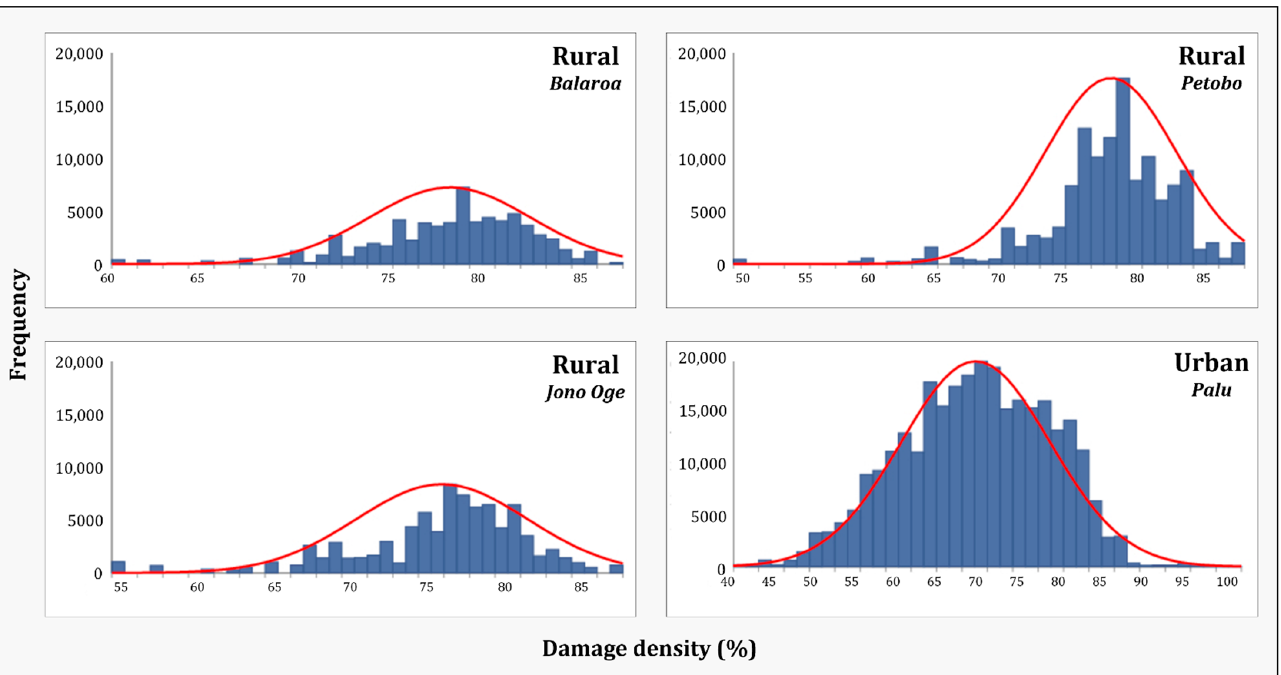
Figure 12. Damage level value distribution of the rural (Balaroa, Petobo, Jono Oge) and the urban (Palu) areas.